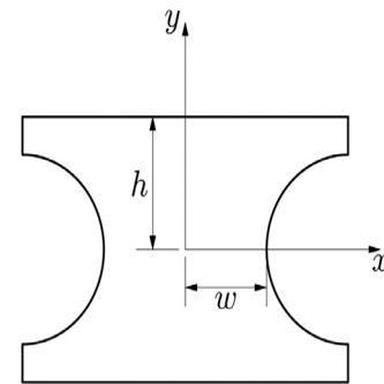
Schematic of the reference frame adopted for the virtual fields definition.